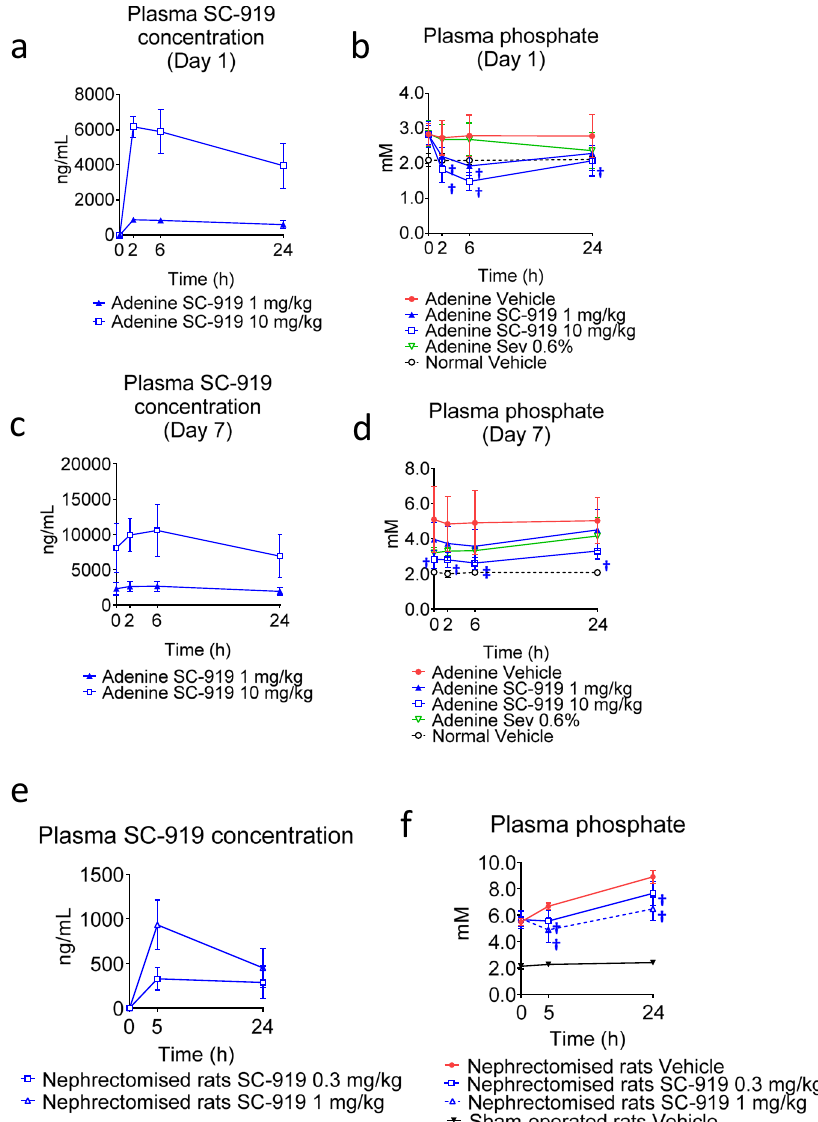
Fig. 4 IP6K inhibition decreases the plasma phosphate levels in rats with hyperphosphataemia. a Concentration of SC-919 and b plasma phosphate levels following the initial dose of SC-919 or sevelamer in adenine-treated rats. ( n = 3 biological replicates for pharmacokinetics and n = 6 and 5 biological replicates for adenine-treated rats and normal rats for determination of phosphate levels in the plasma). c Concentration of SC-919 and d plasma phosphate levels following the seventh dose of SC-919 or sevelamer in adenine-treated rats. ( n = 3 biological replicates for pharmacokinetics and n = 6 and 5 biological replicates for adenine-treated rats and normal rats for determination of phosphate levels in the plasma). e Concentration of SC-919 and f plasma phosphate levels in bilaterally nephrectomized rats that were orally administered with SC-919. Animals found dead during the study (1 rat in SC-919 1 mg/kg of e , 2 rats in nephrectomized-vehicle, and 1 rat in nephrectomized-SC-919 1 mg/kg of f . ( n = 5 – 7 biological replicates for nephrectomzed rats, and n = 6 biological replicates for sham-operated rats for e and f ). Values indicate mean ± S.D. † P < 0.05 and ‡ P < 0.05 vs. vehicle as determined using a Williams ’ test and the Shirley – Williams test, respectively. Sev